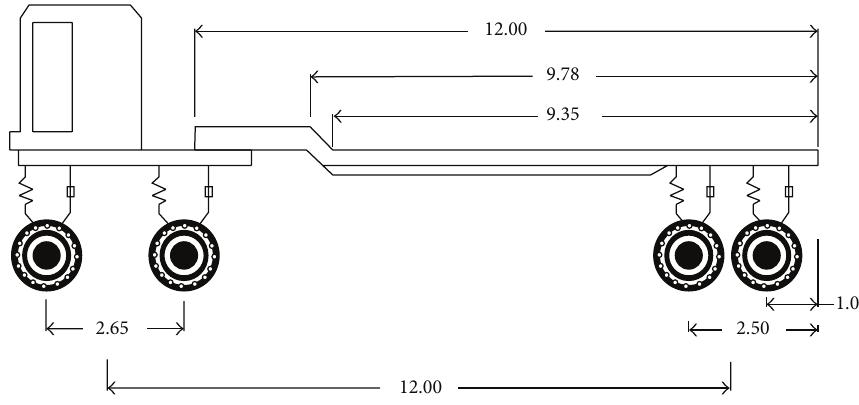
Figure 4: Longitudinal section of vehicle (all dimensions are in